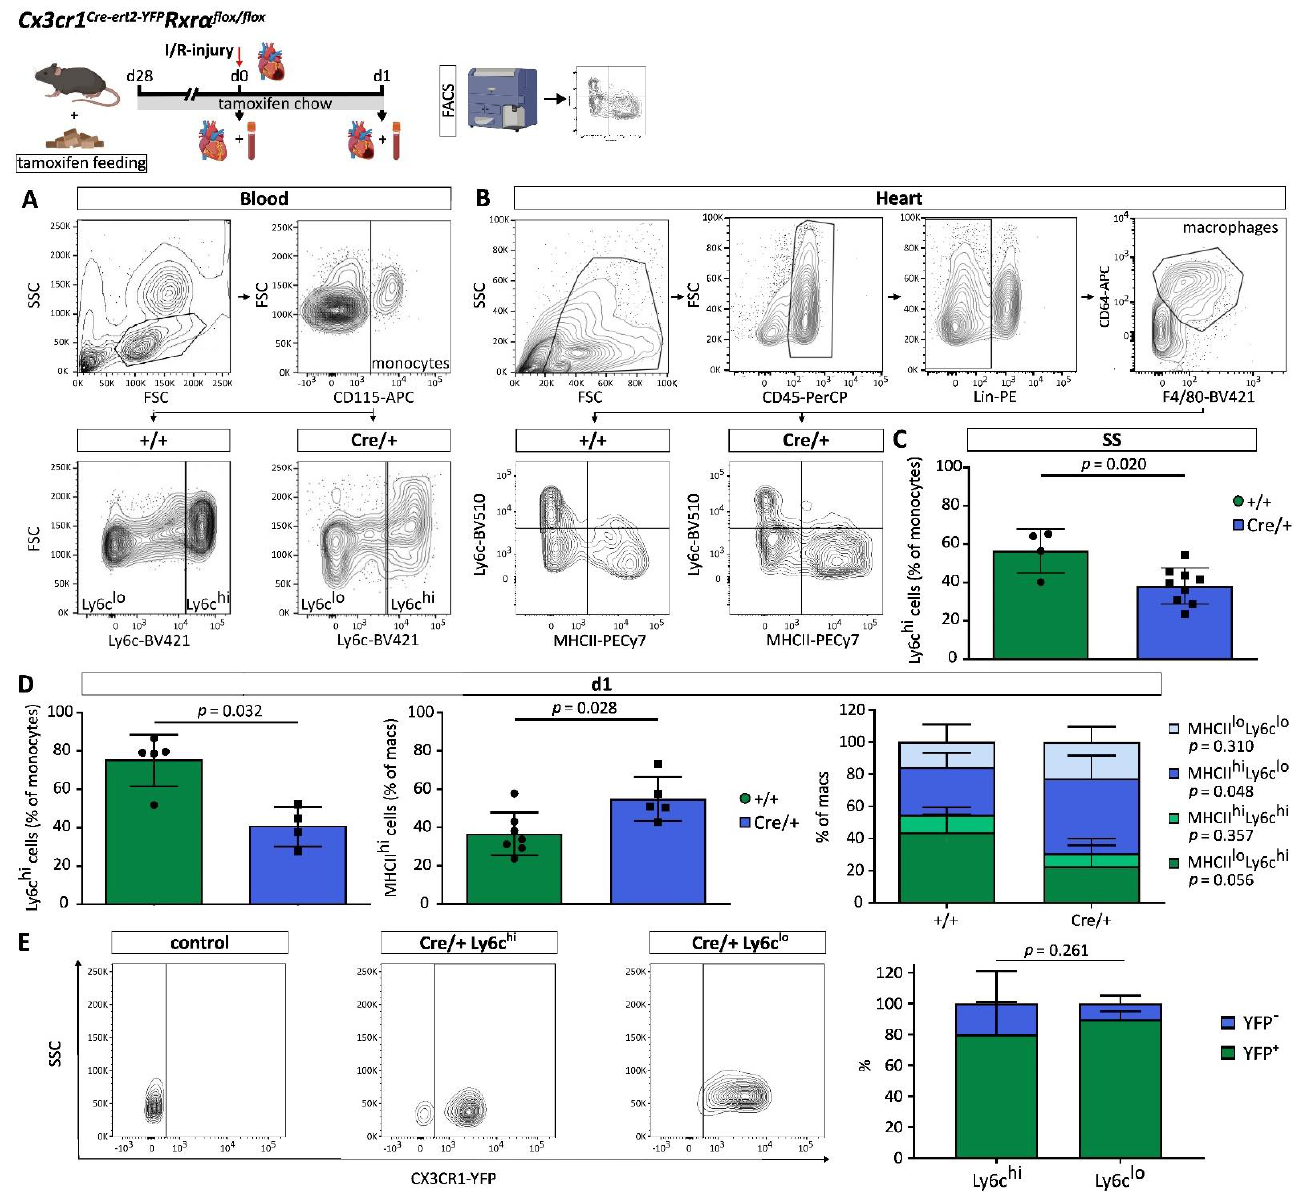
Figure 2. Reduced Rxr α expression in myeloid cells influences monocyte and macrophage subset composition. ( A ) FACS gating strategy to assess monocyte subsets in peripheral blood; ( B ) FACS gating strategy to analyze cardiac macrophage populations; ( C ) amount of Ly6c hi monocytes in PB during steady state in Cx3cr1 ∆ Rxr α compared to control mice; ( D ) proportions of Ly6c hi monocytes in PB and MHCII hi macrophages in the heart of Cx3cr1 ∆ Rxr α in relation to control mice on d1 after I/R injury; ( E ) intrinsic YFP expression in Ly6c hi versus Ly6c lo monocytes of Cre/+ compared to control mice. Flowchart was created with BioRender.com. control (+/+): control mice [littermates with a floxed Rxr α allele but without Cre expression]; Cx3cr1 ∆ Rxr α (Cre/+): mice with a floxed Rxr α allele and Cre expression; FACS: fluorescence activated cell sorting; FSC: forward scatter; hi: high; I/R injury: Ischemia/Reperfusion injury; lo: low; Lin: Lineage; macs: macrophages; Rxr: Retinoid X receptor; SS: Steady state; SSC: sideward